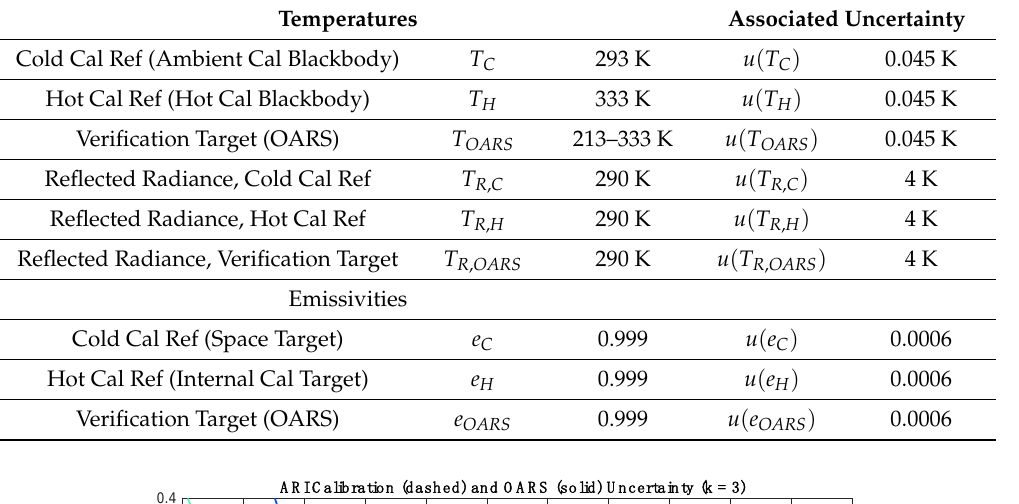
Table 4. Uncertainty estimates used in the radiometric uncertainty analysis for laboratory configuration. All specified uncertainties correspond to a k = 3 coverage factor.